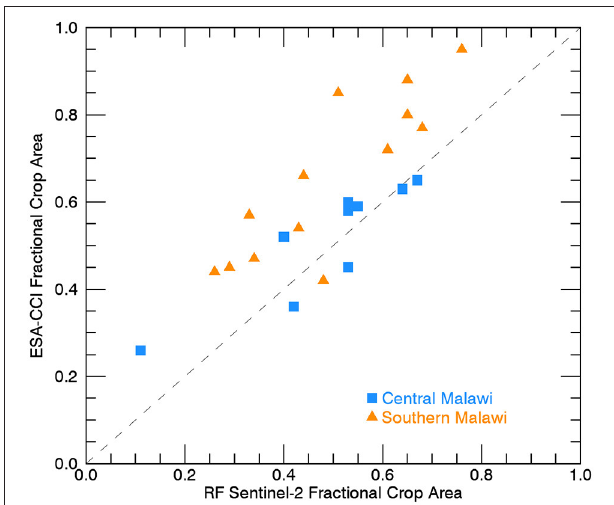
FIGURE 5 | Fractional crop area compared for the RF Sentinel-2 map and the ESA-CCI map. The ESA-CCI map overpredicts crop area by 10–20% for many of the districts in southern